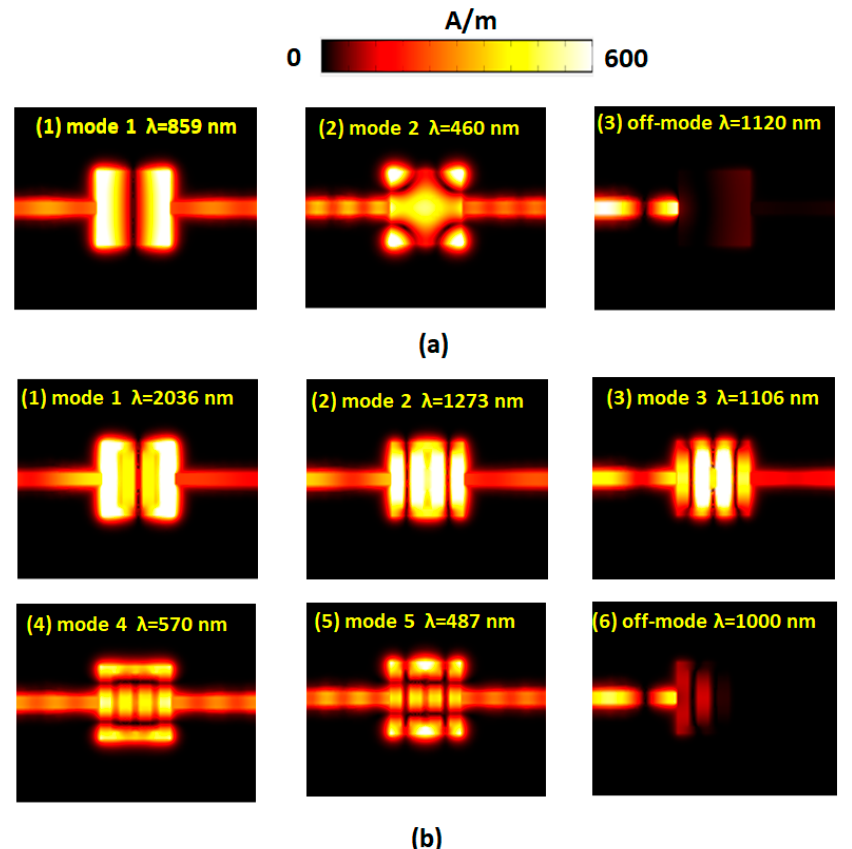
Figure 3. Truncate views of magnetic field intensity ( | H | ) for the cases ( a ) without Ag ba ffl es at λ res = 859 and 460 nm and ( b ) with Ag ba ffl es at λ res = 2036, 1273, 1106, 570, and 487 nm, concerning L = 300 nm, respectively. The off-resonance modes for the case without Ag baffles (at λ = 1120 nm) and the case with Ag baffles (at λ = 1000 nm) are also illustrated for comparison.